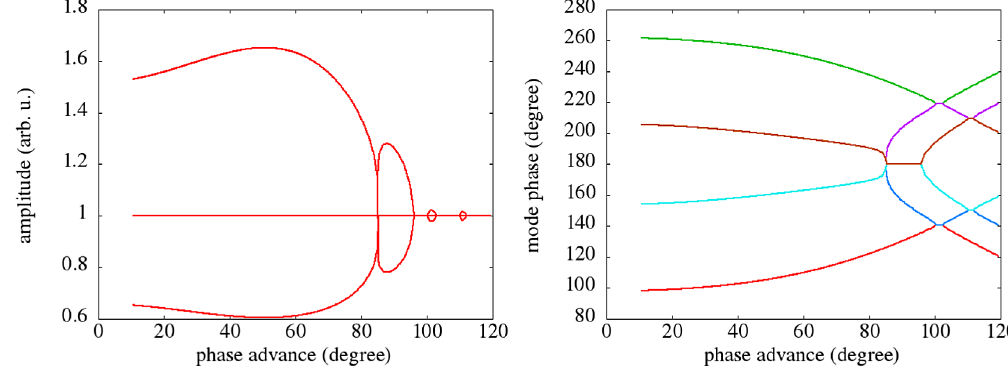
FIG. 15. The 3D envelope mode (left) growth rate amplitudes and (right) phases as a function of the horizontal depressed phase advances with zero current phase advances 120 ° in horizontal, 110 ° in vertical, and 80 ° in longitudinal direction in a periodic quadrupole-rf channel. The six colors in the right plot are the phases of the six